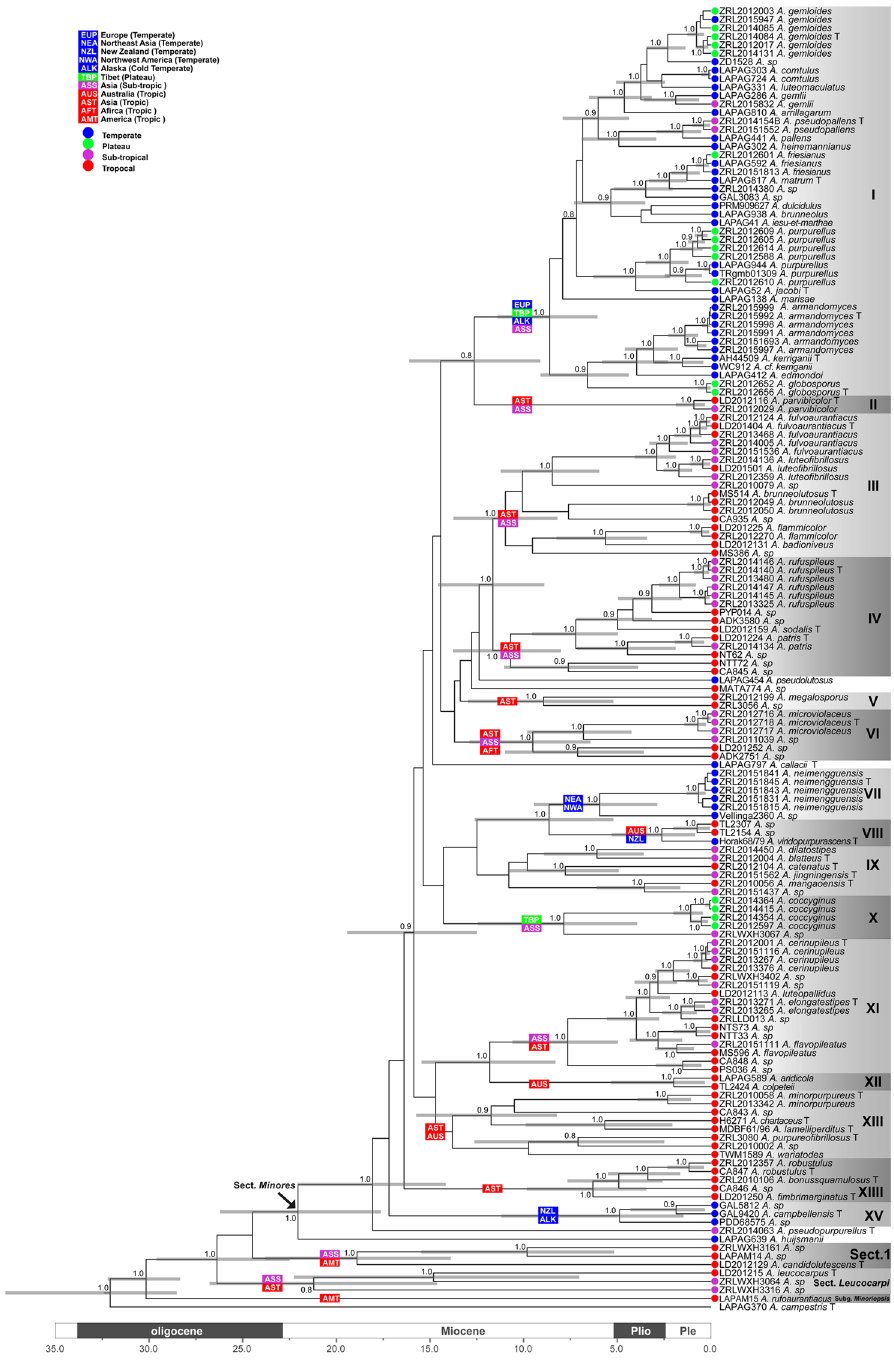
Figure 2. Maximium Clade Credibility (MCC) tree of Agaricus subgenus Minores based on LSU, tef1- α , rpb2 and ITS sequences with the outgroup Agaricus campestris . Posterior probability equal and above 0.8 are indicated at the nodes. The 95% highest posterior density (HPD) of divergence time estimation is marked by horizontal